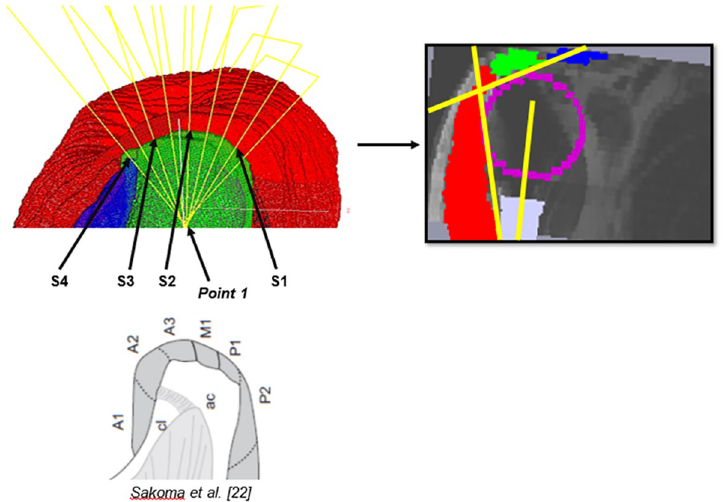
Fig 4. Plane Slices selection and angle measurements. (A) Point 2 changes on each slice: S4 = A2, S3 = A3, S2 = M1 and S4 = P1. (B) Each plane slice includes a MD string (red), a pulley (part of the ILSS, purple), a part of the acromion (green) and of the clavicle (blue). The CER is computed using the ^ T and ^ E measurements with the straight yellow lines. (C) Caption credit: Sakoma et al . [22].